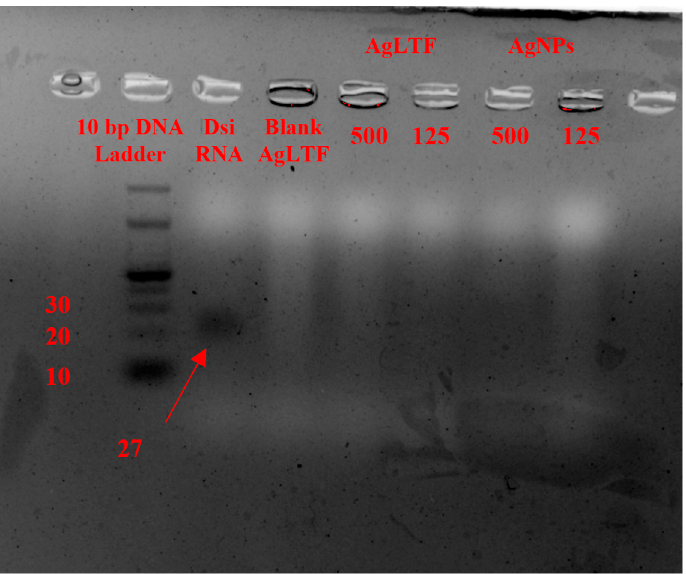
Figure 4. Gel electrophoresis of AgLTF-DsiRNA and AgNP-DsiRNA at 500 and 125 µg/mL.